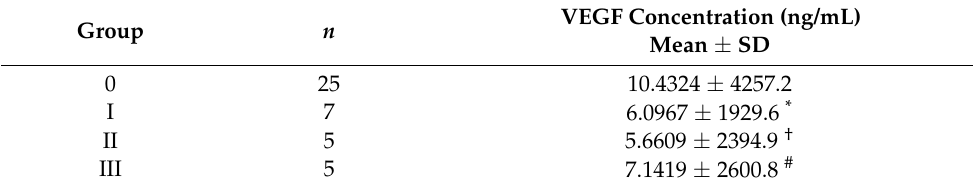
Figure 3. VEGF concentration in all groups of patients: group I (NSAIDs), group II (antibiotics), group II (NSAID and antibiotics) and control group (no drug treatment). Table 1. Differences of VEGF concentration among tested groups and the control